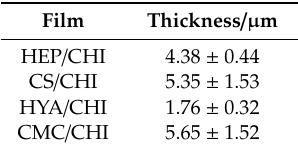
Figure 4. Cross-sectional SEM images of polysaccharide composite films composed of HEP / CHI ( a ), CS / CHI ( b ), HYA / CHI ( c ), and CMC / CHI ( d ). Table 2. Thickness of polysaccharide composite films.